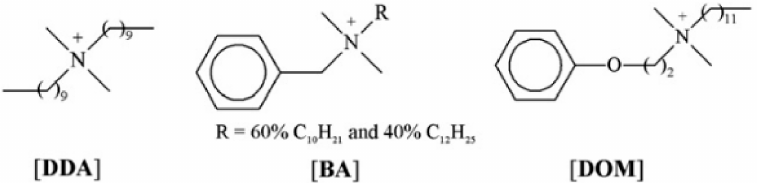
Figure 3. Structures of the cations including didecyldimethylammonium DDA, benzalkonium BA, and domiphen [N,N-dimethyl-N-(2-phenoxyethyl)-1-dodecanaminium] [DOM]. Adapted from